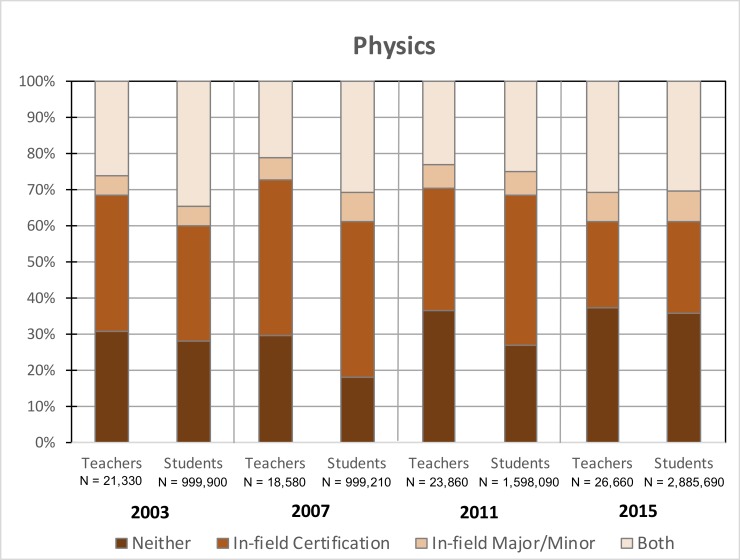
Percentages of in-field and out-of-field high school physics teachers and high school physics students assigned to these educators from 2003–2015.CV teachers < .017; CV students < .011; SEteachers ≤ 10%; SEstudents ≤ 6%.